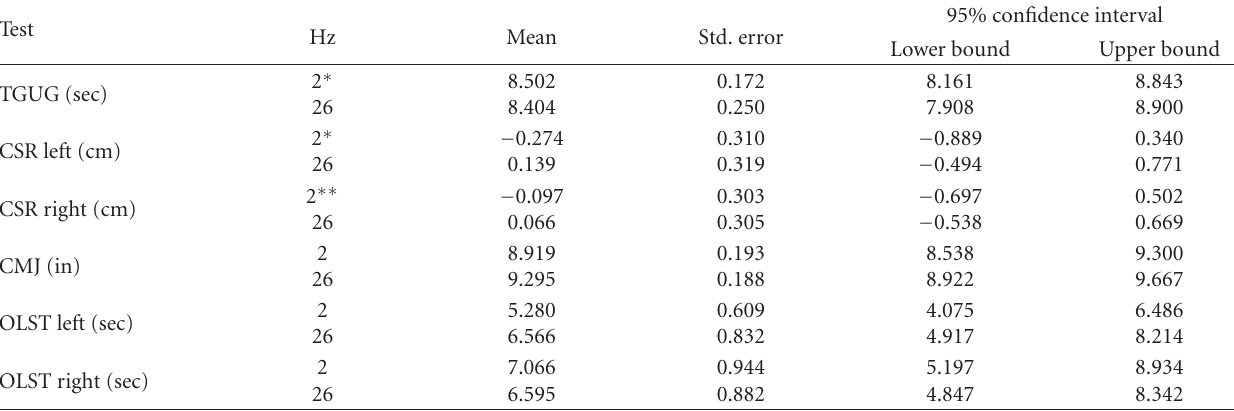
Table 1: Means, standard errors and 95% confidence intervals for 4 outcome measures in 32 community-dwelling older adults (mean age